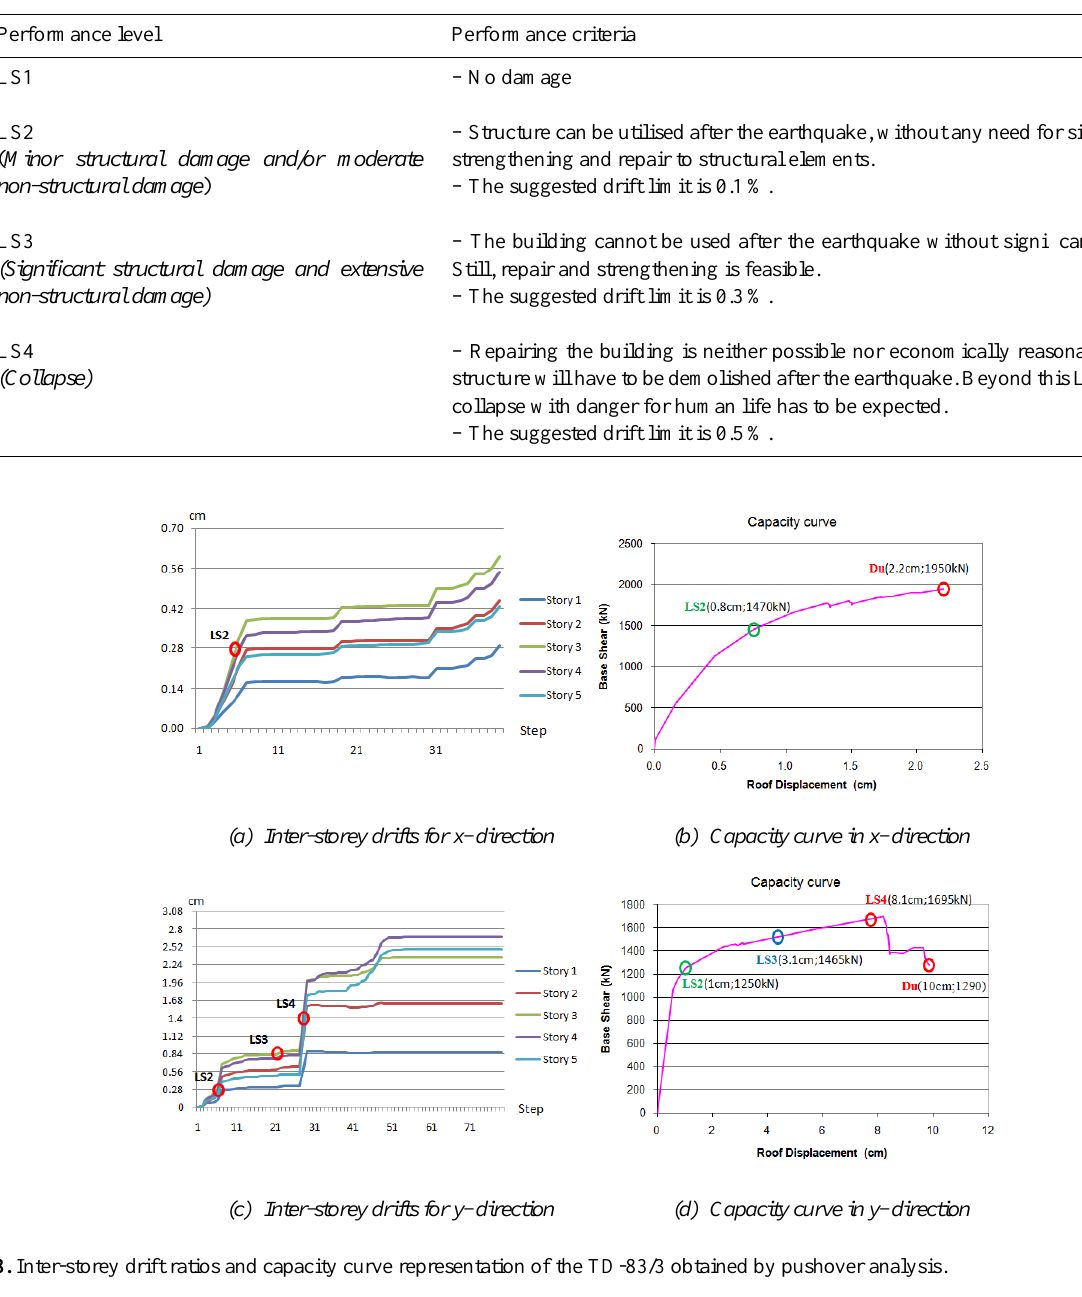
Table 1. Performance levels and criteria provided by Calvi (1999).